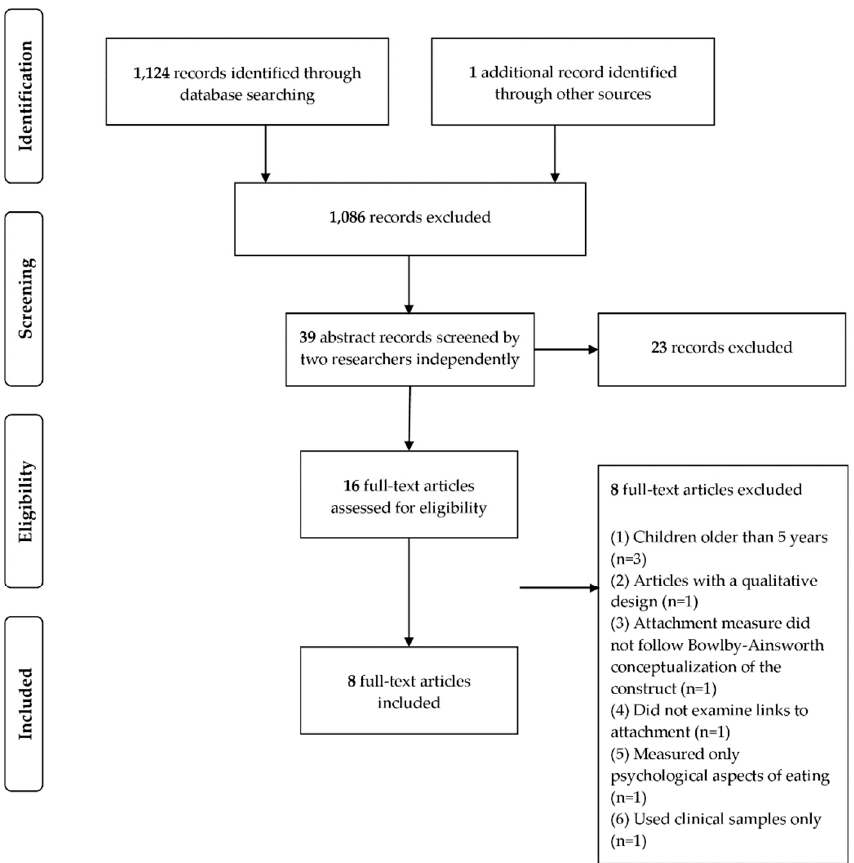
Figure 1. Flow diagram depicting study identification and selection process.